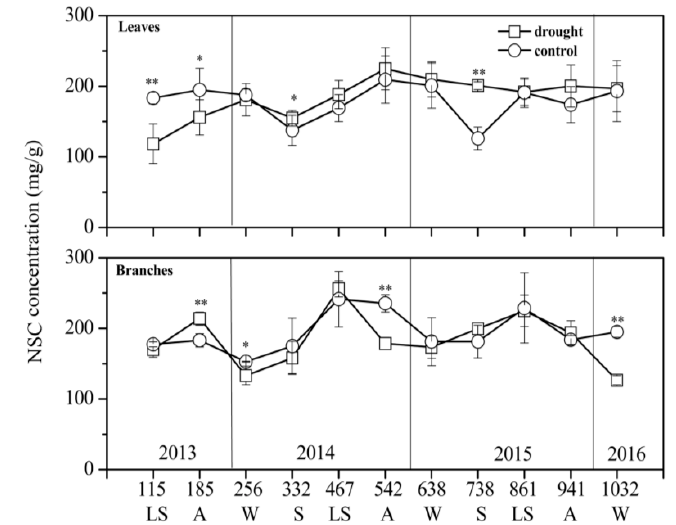
Figure 4. Non-structural carbohydrates (NSCs) in the leaves and branches of Pinus massoniana under control and drought treatments (mean ± SD). Samples were collected in late summer (LS), autumn (A), winter (W), and late spring (S) from 2013 to 2016. Variables marked with asterisks indicate a significant difference between the control and drought groups (** p < 0.01, * p < 0.05).